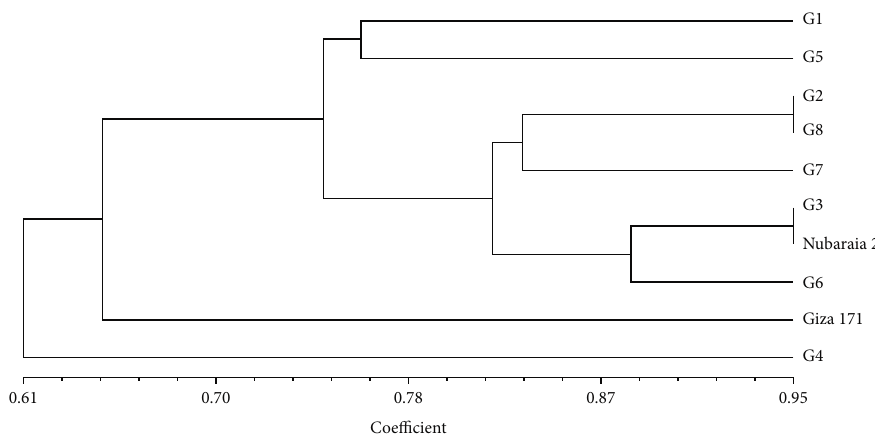
Figure 5: Cluster analyses of the 10 wheat genotypes based on SDS-PAGE